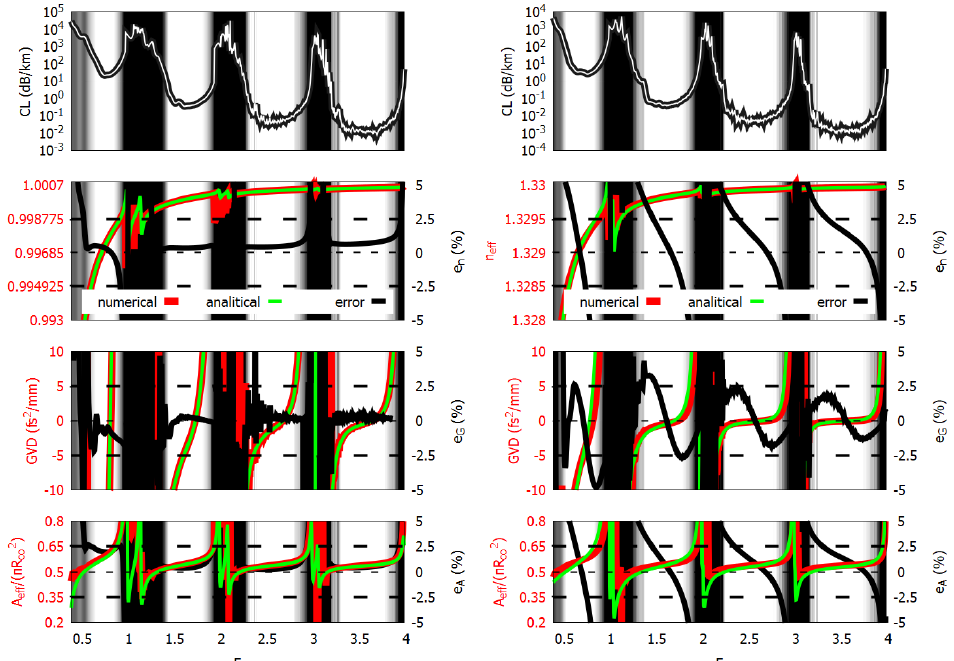
Figure 9. Confinement loss ( top row ), effective index ( top-central row ), group velocity dispersion ( bottom-central row ), and effective area ( bottom row ) of fiber F#2 with n g = 1.0007 ( left ) and n g = 1.33 ( right ). Dark areas correspond to high-loss regions. For effective index, group velocity dispersion, and effective area, solid green, red, and black curves show numerical and analytical result, and relative error, respectively.